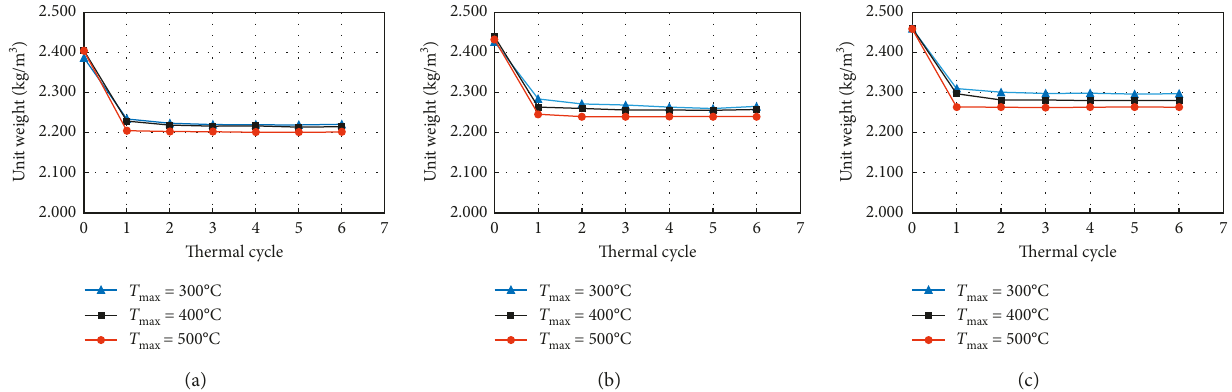
Figure 7: Variations in unit weight during thermal cycling at different maximum temperatures. (a) Steel fiber content � 1.0%. (b) Steel fiber content � 1.5%. (c) Steel fiber content �